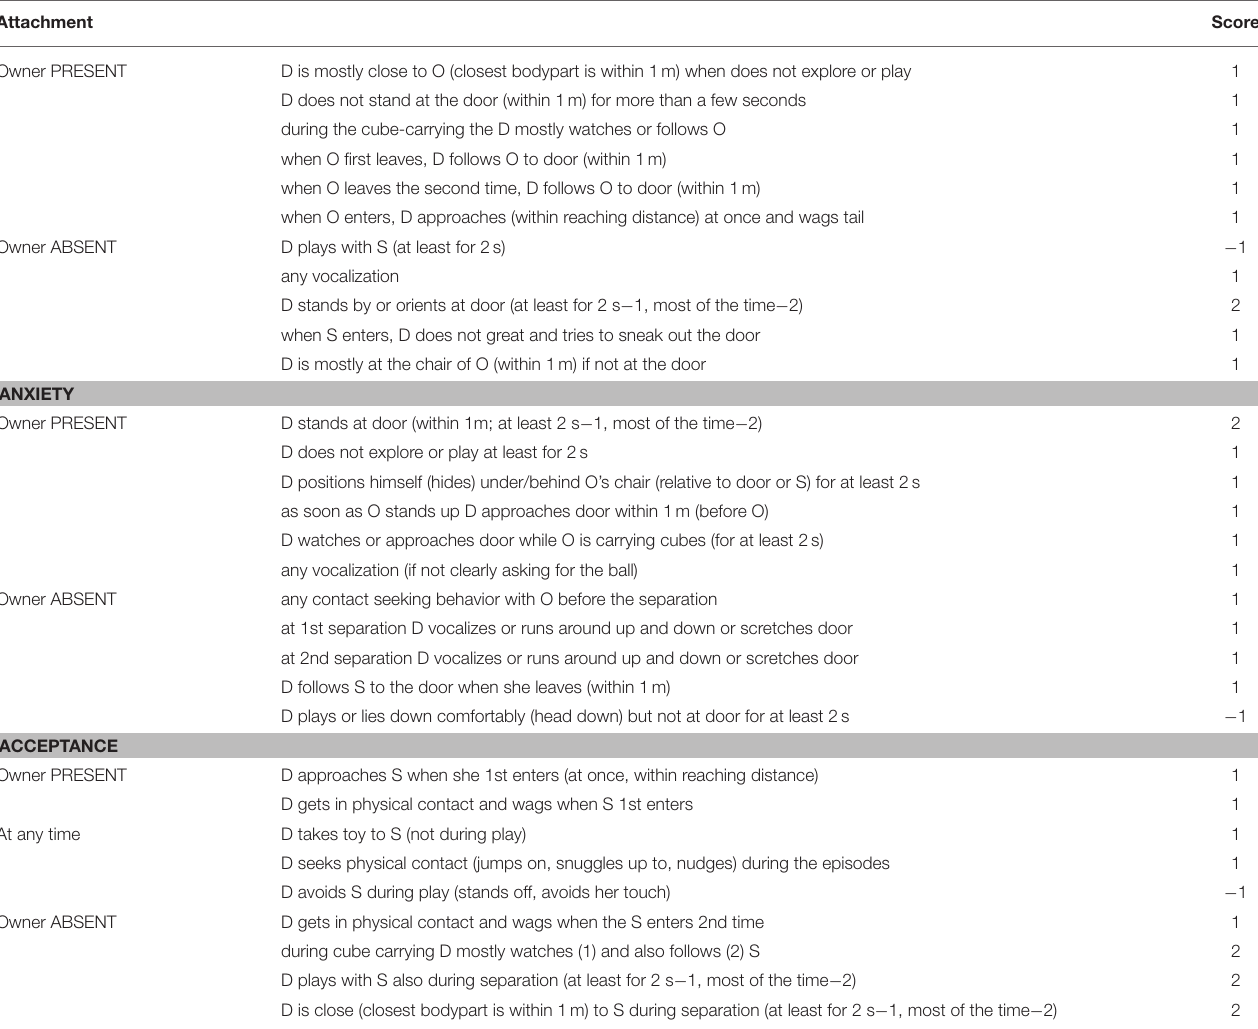
TABLE 3 | Behavior variables observed in Strange Situation Test (D, dog; S, stranger; O, owner). Attachment